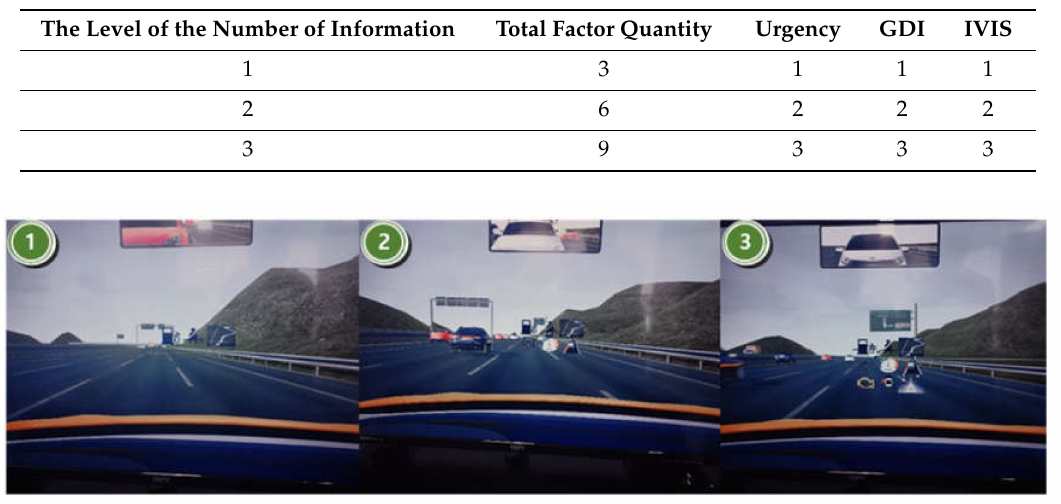
Table 2. Composition of the three levels describing the number of information.